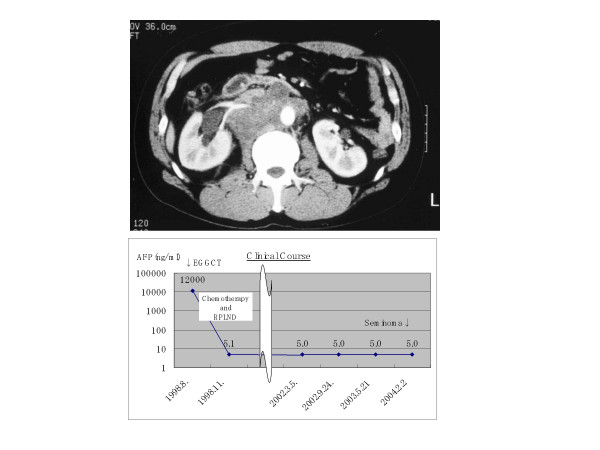
CT shows a retroperitoneal bulky mass. (B) The clinical course from the treatment of EGGCT to that of seminoma.